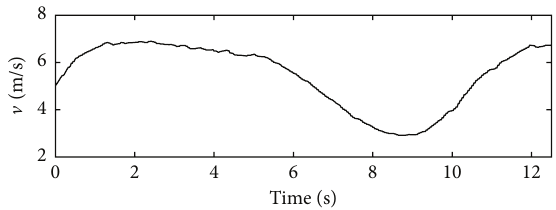
Figure 20: Velocity of obstacle avoidance at medium speeds.